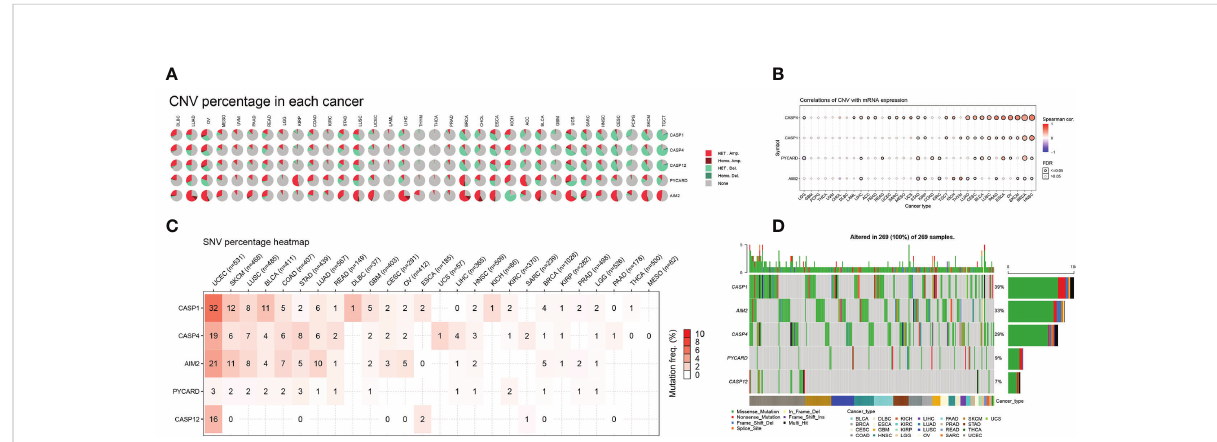
FIGURE 2 Distribution of copy number variation (CNV) pie charts for AIM2 in fl ammasome-related genes (AIM2i-RGs) with oncogene variant analysis in 33 tumors (A) Each CNV pie chart represents the CNV combinations of homozygous/heterozygotes of each AIM2i-RGs in each tumor. A single pie represents the proportional distribution of the different types of CNVs for a single gene in single cancer, with different colors representing the different types of CNVs. Heterozygous Ampli fi cation and Heterozygous Ampli fi cation; Homozygous Ampli fi cation and Homozygous Ampli fi cation; Heterozygous Deletion and Heterozygous Deletion; Homozygous Deletion and Homozygous Deletion; None, no CNV. (B) Correlation of CNV with mRNA expression. The size of the points represents statistical signi fi cance; the larger the point, the higher the statistical signi fi cance (Spearman ’ s correlation test). (C) Single nucleotide variant (SNV) frequencies of AIM2i-RGs in 26 tumors. Color shades represent the magnitude of mutation frequencies. The number size represents the frequency of samples with the corresponding mutated gene for particular cancer. No number indicates that no mutation has occurred in any region of the gene, and “ 0 ” indicates that no mutation has occurred in the coding region of the gene. (D) SNV Oncoplot. The side and top bar graphs show the number of variants in each sample or